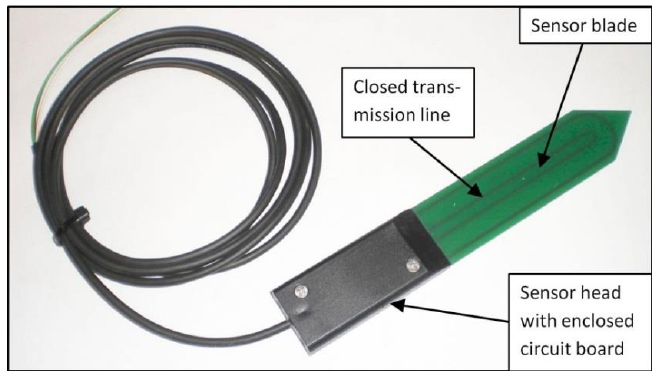
Figure 1. The SMT100 soil water content sensor.